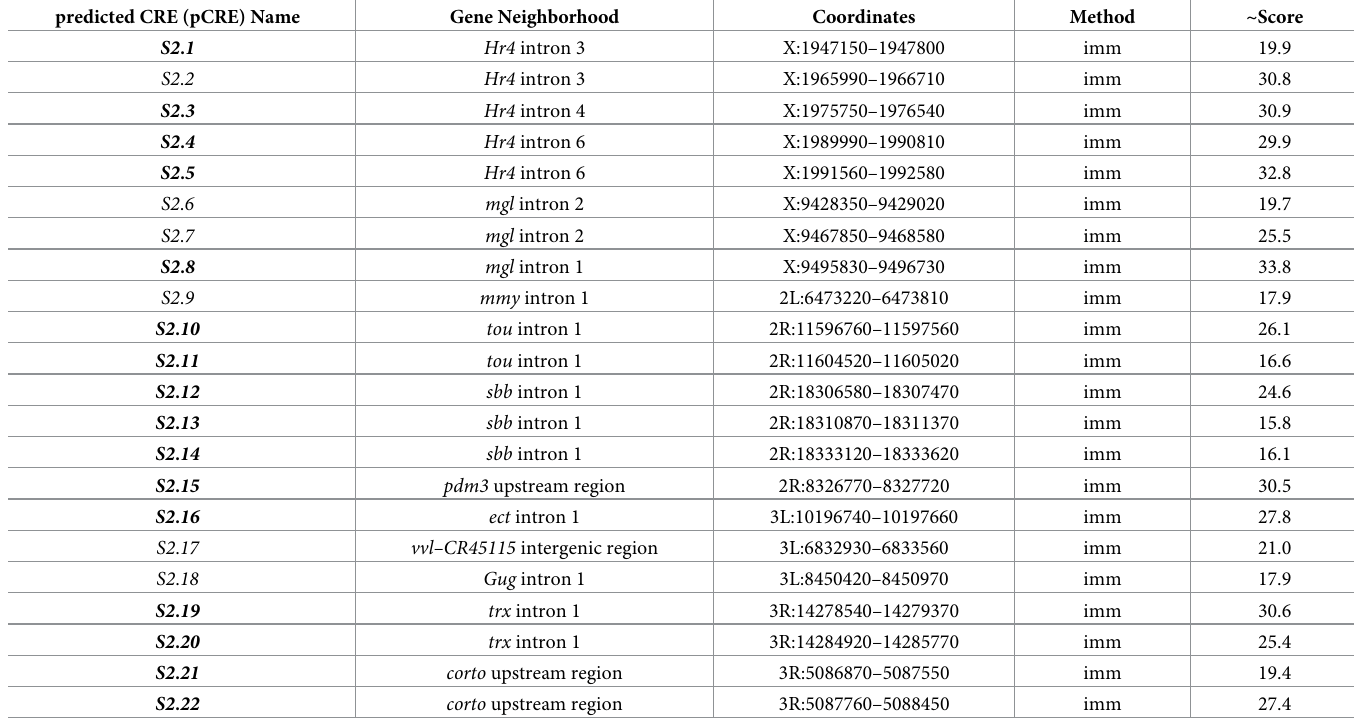
Note: pCREs with bolded font were those found to drive robust EGFP reporter expression in the developing pupal